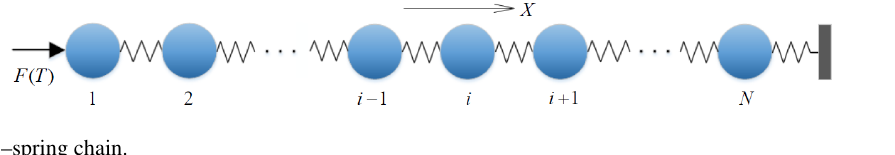
fixed at the right end and loaded by an external force F(T ) from the left end (Fig.